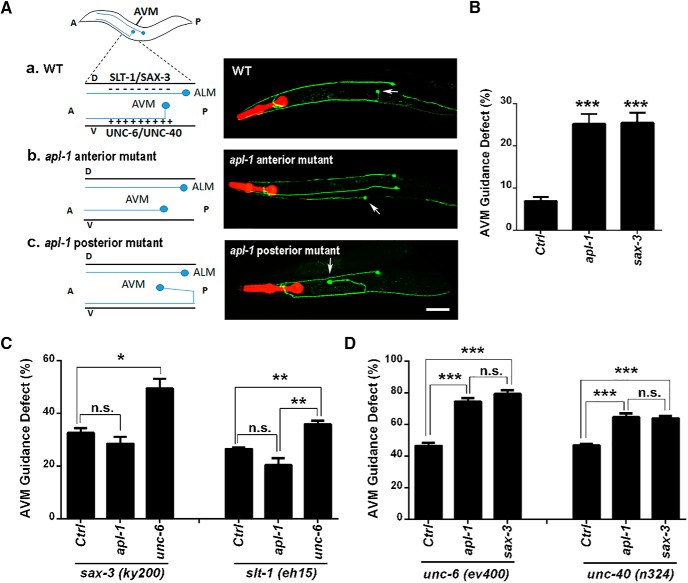
APL-1 deficiency in C. elegans affects AVM neuron ventral axon guidance. A, Schematic diagram and representative fluorescence images of mechanosensory ALM and AVM neurons (arrows) visualized by zdIs5[mec-4:gfp] in WT (a) and apl-1 knock-down worms (b, c). In WT C. elegans, dorsally expressed SLT-1/SAX-3 repels whereas ventrally expressed UNC-6/UNC-40 attracts AVM axons to grow toward ventral nerve cord before extending anteriorly to the nerve ring. In worms with apl-1 RNAi, AVM axons extend anteriorly (b) or posteriorly (c) instead of growing ventrally first. A, anterior; P, posterior; D, dorsal; V, ventral. Scale bar, 50 μm. B, Quantification of AVM axon guidance deficits in worms (strain MCW451) treated with L4440 empty vector control (Ctrl), apl-1, or sax-3 RNAi for 48 h starting at L1 stage. C, Quantitation of the AVM axon guidance defects in sax-3(ky200) or slt-1(eh15) mutant worms treated with control, apl-1 or unc-6 RNAi. apl-1 RNAi cannot further increase AVM guidance defects in sax-3(ky200) or slt-1(eh15) mutant worms. D, Quantitation of the AVM axon guidance deficits in unc-6(ev400) or unc-40(n324) mutants treated with control (Ctrl), apl-1, or sax-3 RNAi for 48 h. Data represent average ± SEM. Each experiment was repeated in five to six independent batches with GFP RNAi showing invisible AVM neurons in >85% of the worms in each batch. Total number of worms counted for each genotype was between 197 and 643. One-way ANOVA (B) and two-way ANOVA followed by the Bonferroni multiple comparison posttest (C, D) were used. *p < 0.05; **p < 0.01; ***p < 0.001; n.s., nonsignificant.